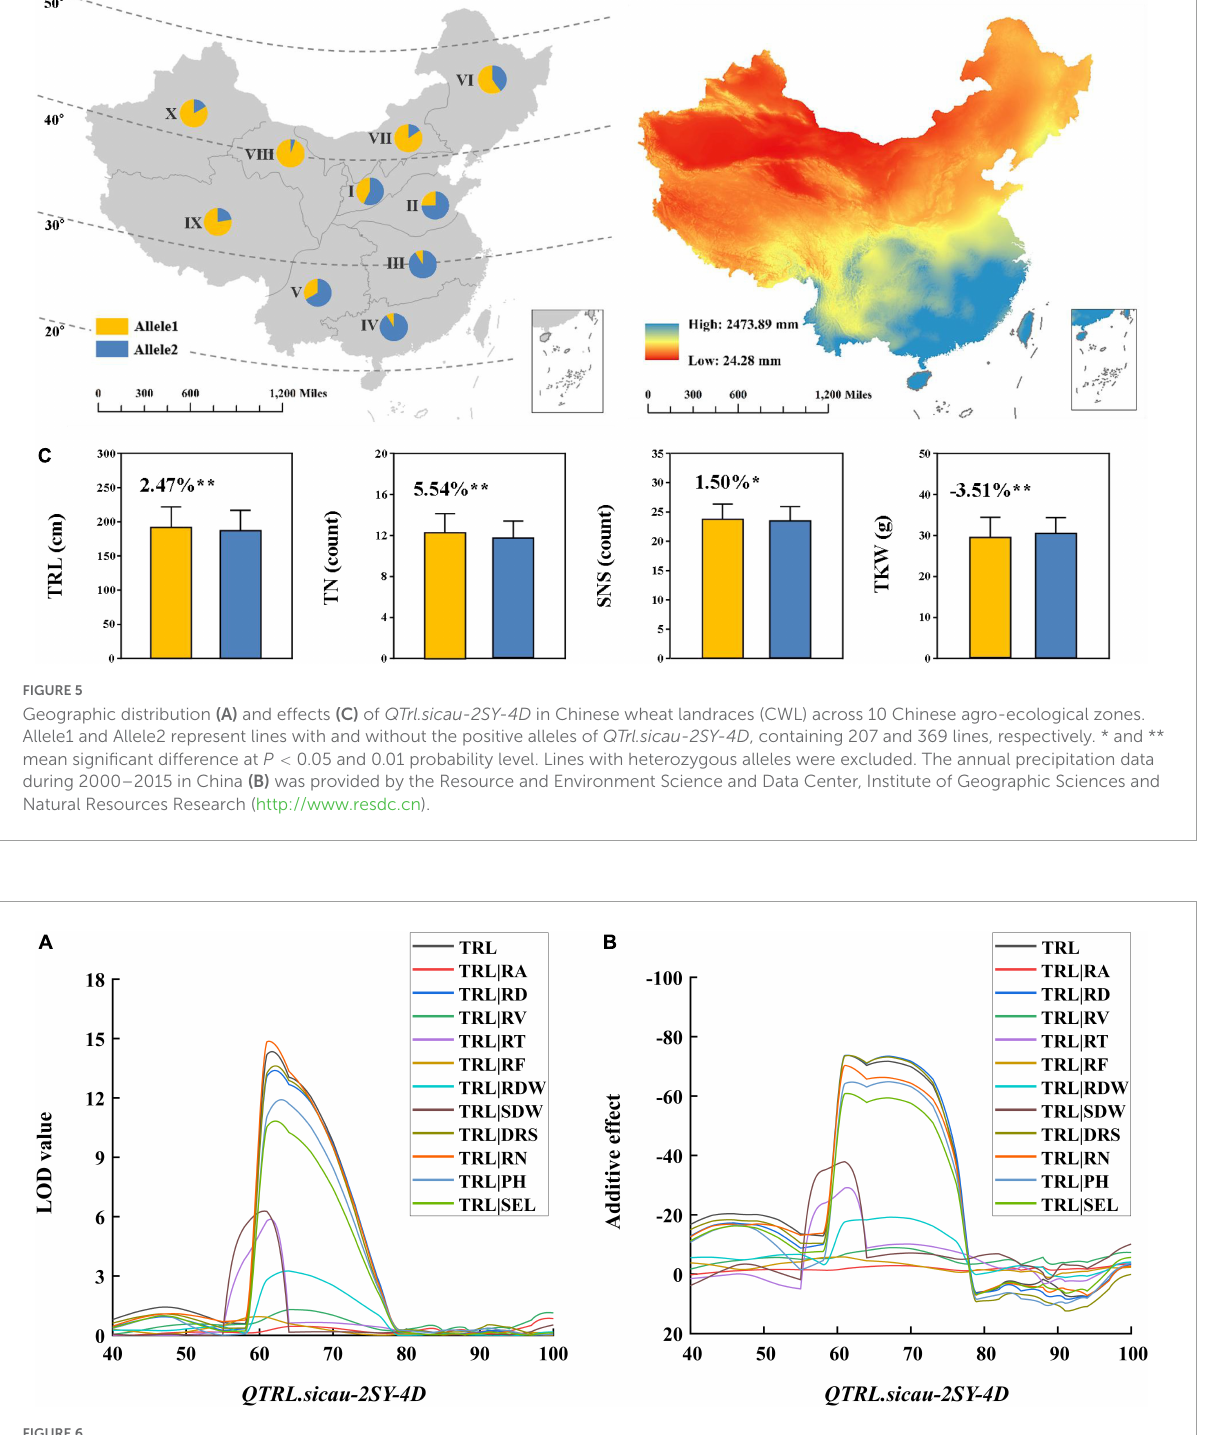
FIGURE6 Logarithm of odds (LOD) (A) and additive effect (B) values of conditional QTL for total root length (TRL). RA root area, RV root volume, RD root diameter, RT root tips, RF root forks, RDW root dry weight, SDW shoot dry weight, DRS dry root–shoot ratio, RN root number, PH plant height, SEL spike extension